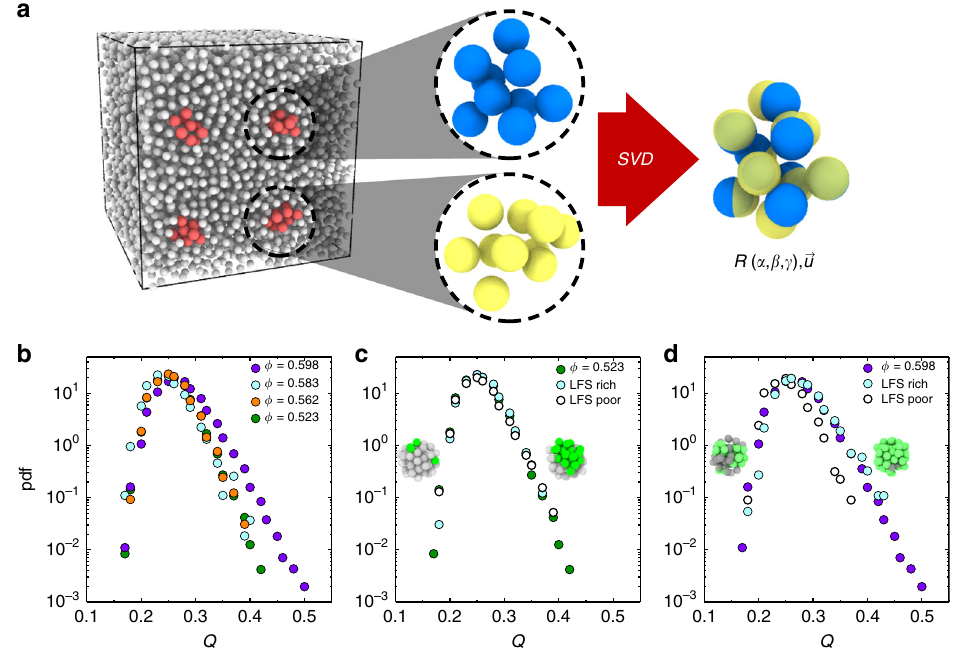
Fig. 4 Static overlap fl uctuations. a Schematic representation of the overlap calculation: isolated clusters of N o particles are subsampled from a large con fi guration; for every pair of clusters, an optimal singular value decomposition (SVD) is found determining the rotation matrix R ( α , γ , β ) and the translation vector ~ u that maximise the overlap. For ease of representation, here N o = 10 and Q = 0.7. b Probability distribution of overlap fl uctuations for volume fractions 0.523, 0.562, 0.583 and 0.598. c , d Overlap fl uctuations for all test spheres, and for the most LFS-poor (white) and rich (blue) 25% test spheres, at volume fractions 0.523 ( c green) and 0.598 ( d purple). c , d Samples of LFS-poor (left) and rich (right) test spheres, where green particles are in defective icosahedra and grey particles are